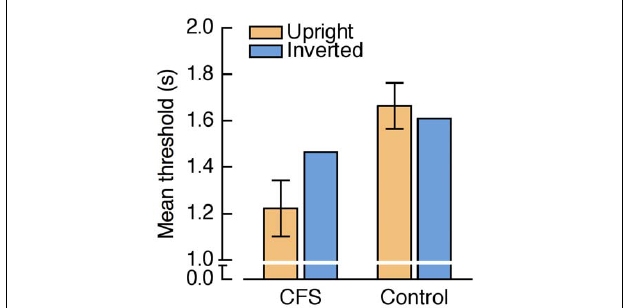
FIGURE 14 | Results from Experiment 6. Mean threshold estimates for upright and inverted faces. Positive and negative error bars denote the 95% confidence intervals for the paired comparisons between upright and inverted faces within each